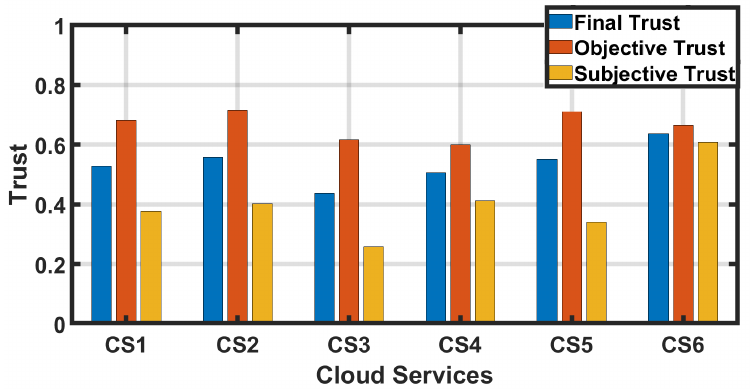
Figure 2. Cloud Services